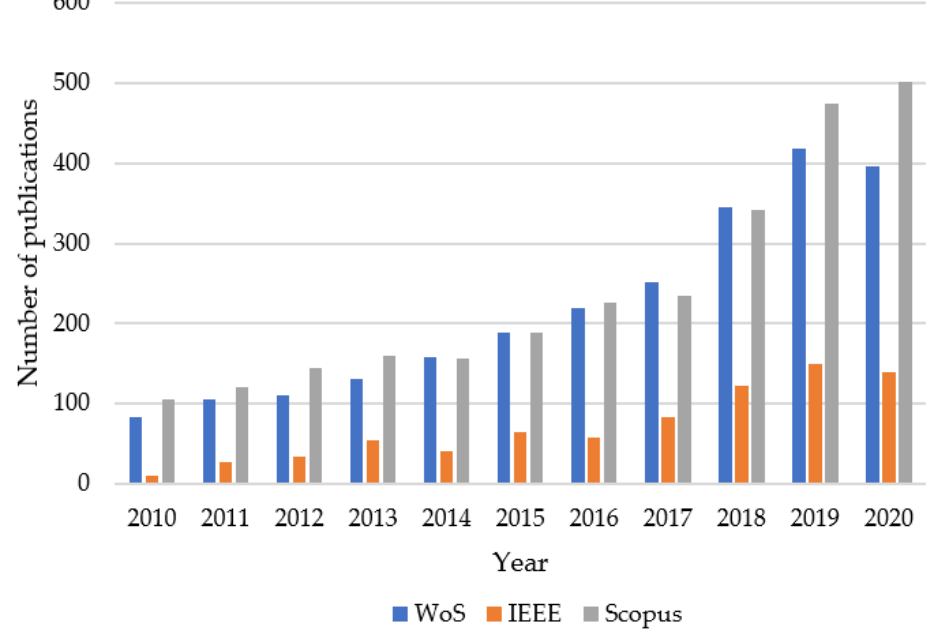
Figure 1. Number of publications with keywords “ARIMA” and “electricity” or “energy” and “volume” or “demand”, “consumption”, “power”, “load” in Clarivate WoS, Scopus, and IEEE Xplore databases.